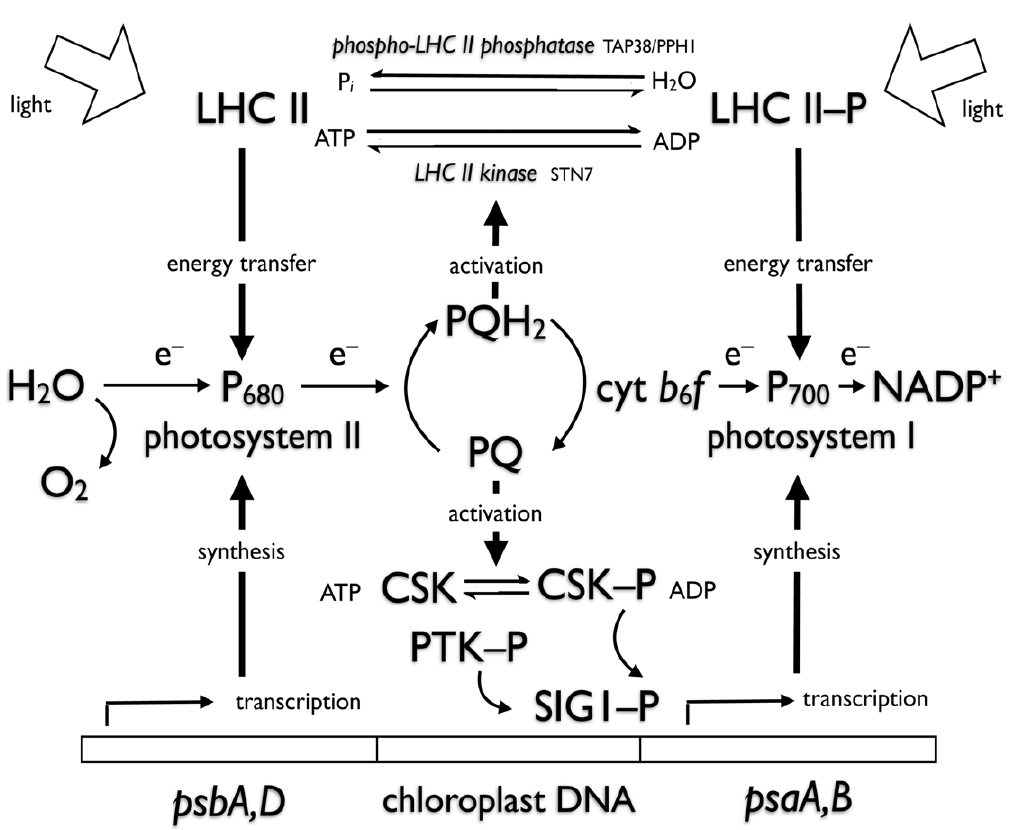
Figure 4. Interactions of photosynthetic electron carriers with redox-signalling components of photosystem stoichiometry adjustment and state transitions. Light reactions of photosynthesis are represented as electron transport from H 2 O to NADP + via two photosystems connected by a cytochrome b 6 f complex which oxidizes plastiquinol (PQH 2 ) to plastoquinone (PQ). CSK senses the redox state of the plastoquinone pool directly by becoming autophosphorylated and activated by PQ. CSK phosphorylation and dephosphorylation initiate transcription of PS II reaction centre ( psbA,D ) and PS I reaction centre ( psaA,B ) genes, respectively, selectively controlling expression of reaction centre genes in chloroplast DNA. The LHC II kinase Stn7 responds to PQH 2 and initiates the state 2 transition, while the phospho-LHC II phosphatase, TAP38/ PPH1, is redox-independent and predominates, inducing the state 1 transition, when PQ is oxidized. Even though they are both controlled by plastoquinone redox state, CSK exerts its transcriptional effect on photosystem stoichiometry independently of the effect of Stn7 in state